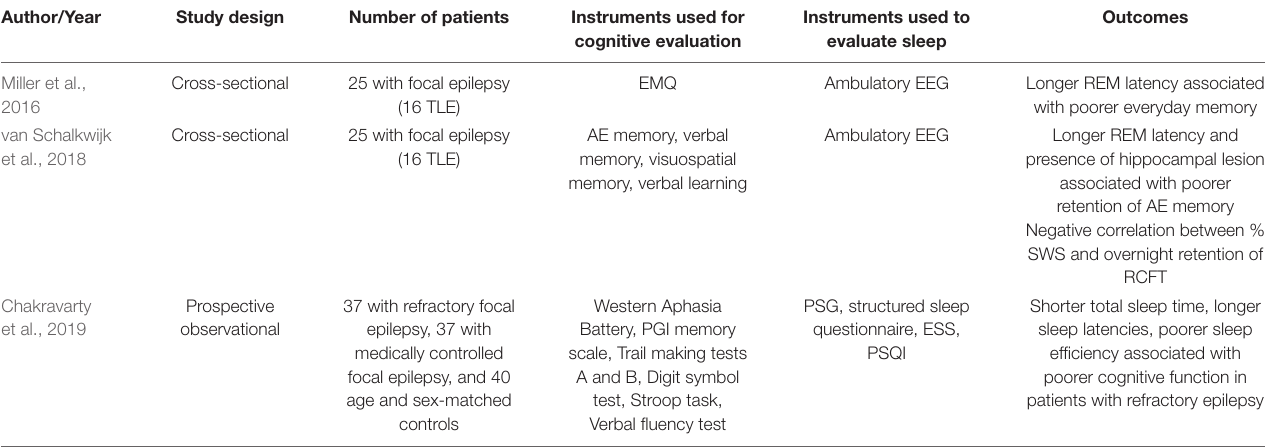
TABLE 6 | Studies assessing impact of sleep on memory and cognition among patients with TLE.